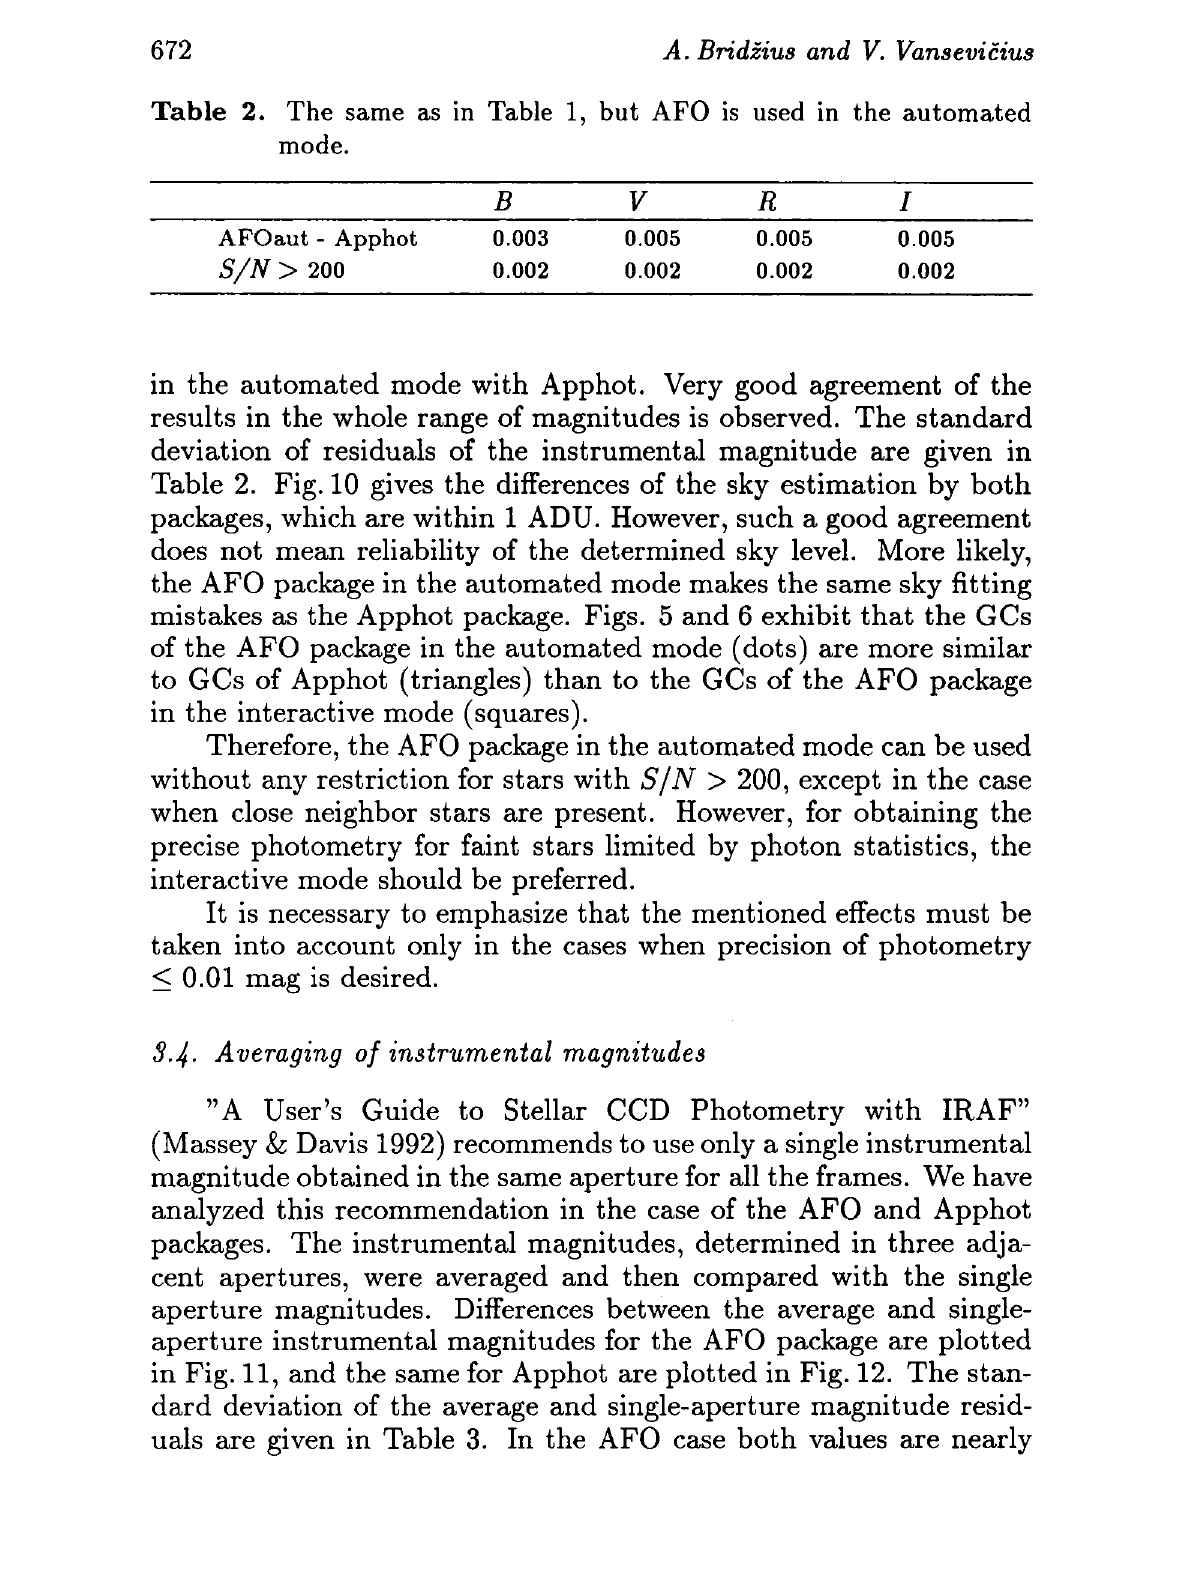
Table 2. The same as in Table 1, but AFO is used in the automated